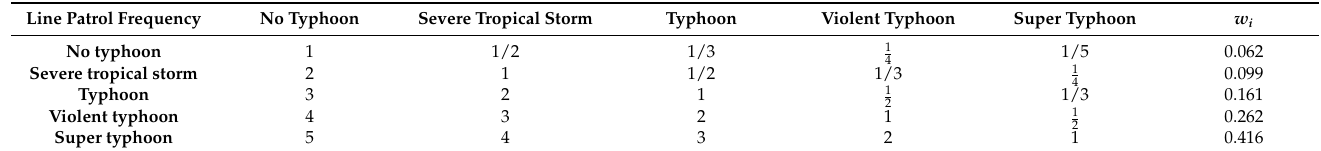
Table 6. Important degree judgment matrix of the frequency of the patrol line under different typhoon intensity.